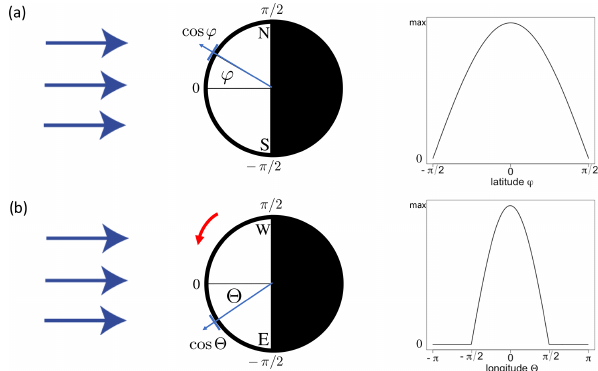
Figure 2. Latitudinal (a) and longitudinal (b) dependence of the in- coming shortwave radiation. On the right-hand side, the insolation as a function of latitude ϕ and longitude (cid:50) with maximum insola- tion (1 − α ) S is shown. See the text for the